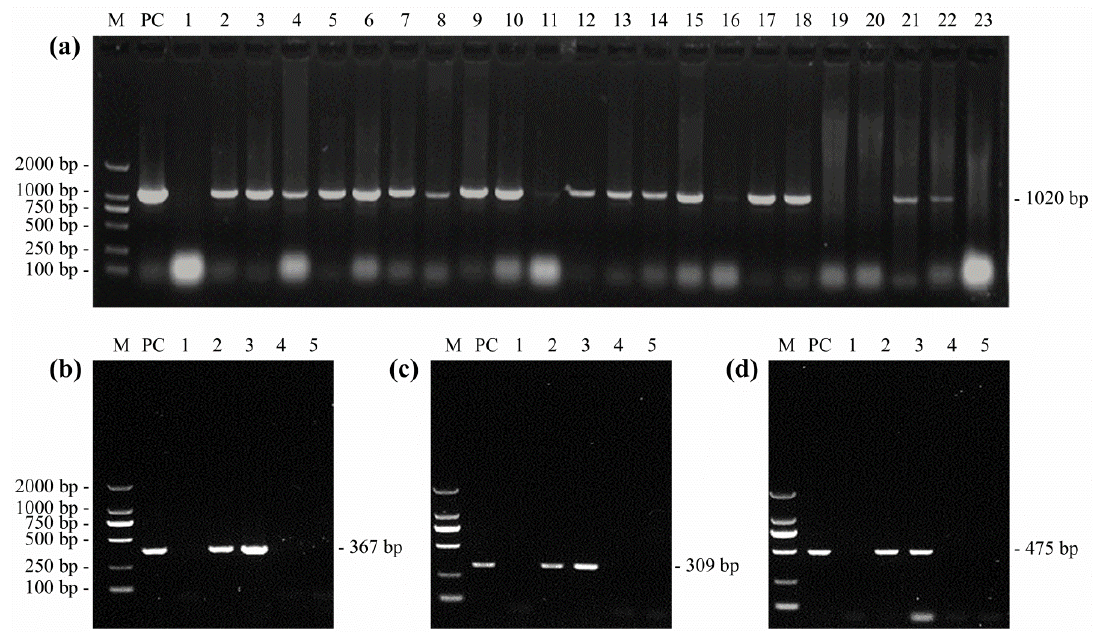
Figure 2. Amplification of MDV and REV specific genes from clinical samples. Amplification of the MDV-1 specific Meq gene by PCR ( a ) and the amplification of REV LTR, gag, or pol genes by RT-PCR ( b – d ). M, DNA marker; PC, positive control; lines 1 – 23 or 1 – 5, numbers of detected clinical samples. Because of space limitations, only part of data are shown here.